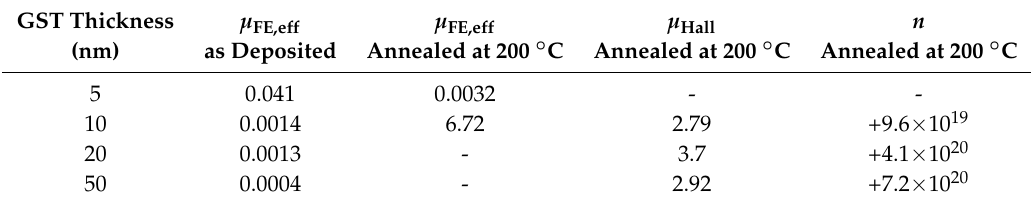
Figure 4. Comparison of the ON-currents and OFF-currents for different GST thicknesses. ( a ) ON- and OFF-currents. ( b ) ON/OFF ratio with a comparison to literature using [19–24]. Table 2. Effective field-effect mobility µ FE,eff (cm 2 /Vs) for TFTs with different GST thicknesses extracted in the linear regime and Hall mobilities µ Hall (cm 2 /Vs) and carrier concentrations n (cm − 3 ) measured in GST